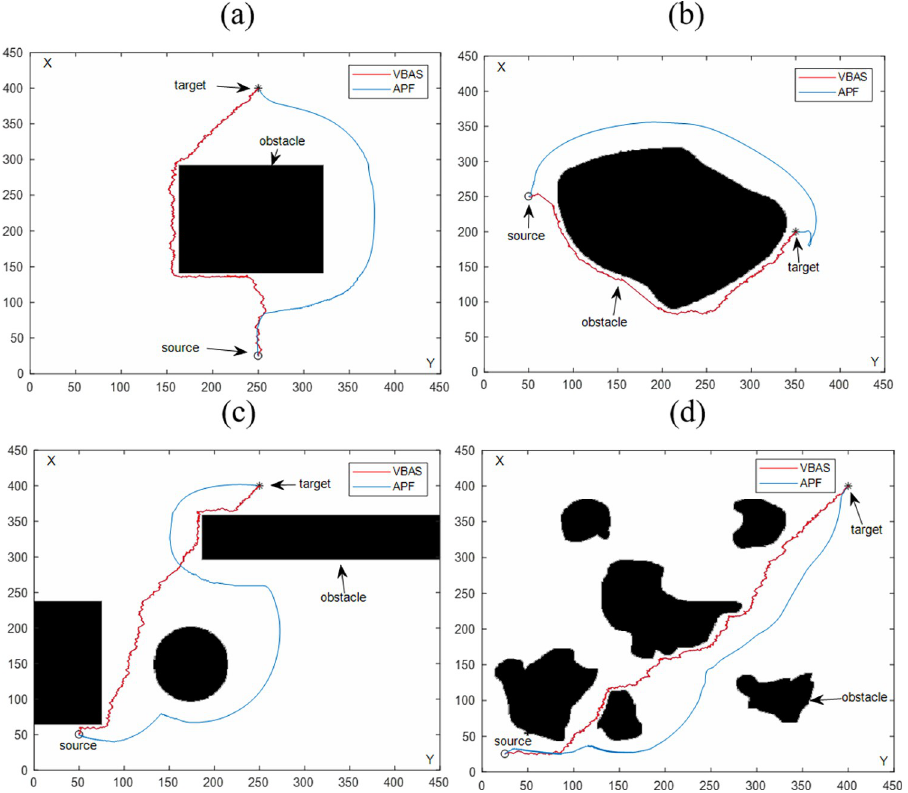
Fig 9. Comparison of obstacle avoidance results between VBAS and APF algorithm. (a) Single regular obstacle. (b) Single irregular obstacle. (c) Multiple regular obstacles. (d) Multiple irregular obstacles.